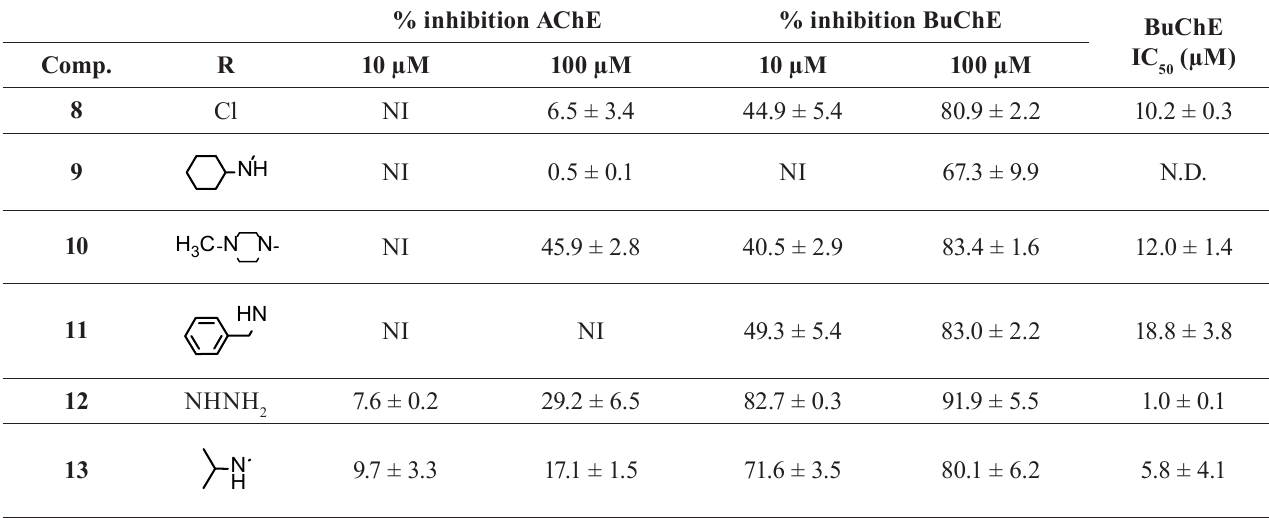
values for BuChE 50